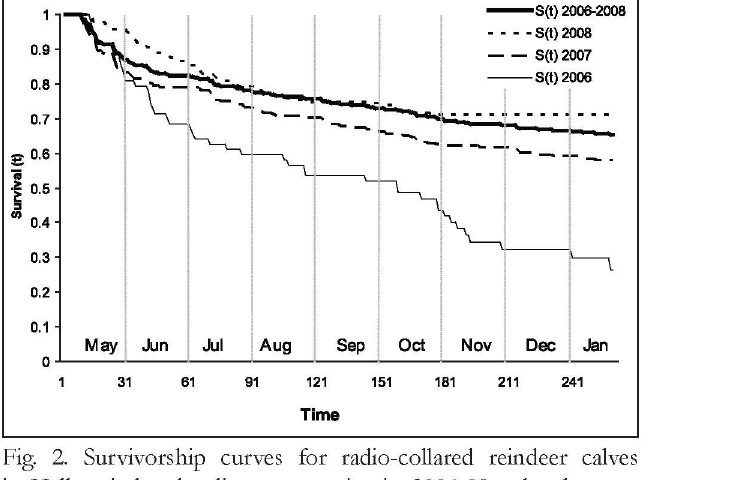
Fig. 2. Survivorship curves for radio-collared reindeer calves in Halla reindeer-herding cooperative in 2006-08, related to ex pressed as days after 1 May (day 1). Total survival curve is S(t) 2006-2008. (Mortality (M) = 1 - Survival (S)).